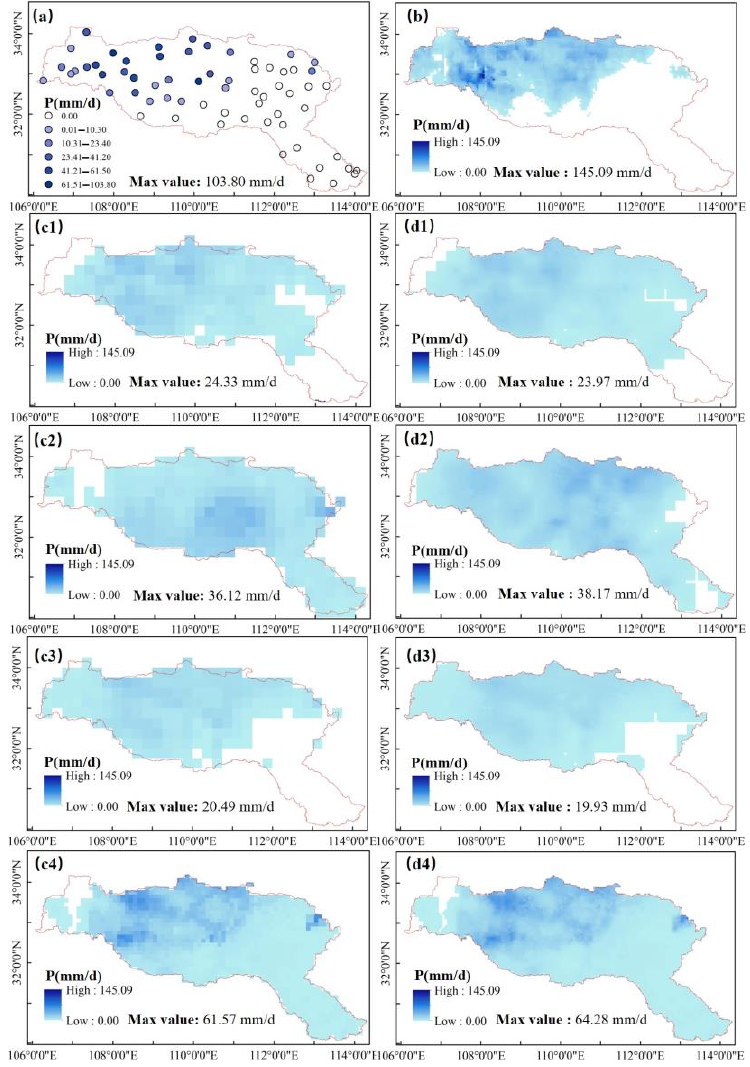
Figure 7. Spatial daily precipitation estimates from ( a ) the rain gauge observation, ( b ) the final MPP with 005 ◦ resolution, ( c1 ) the original 0.25 ◦ resolution TRMM_3B42, ( d1 ) the downscaled 0.05 ◦ resolution TRMM_3B42, ( c2 ) the original 0.25 ◦ resolution PERSIANN-CDR, ( d2 ) the downscaled 0.05 ◦ resolution PERSIANN-CDR, ( c3 ) the original 0.25 ◦ resolution CMORPH, ( d3 ) the downscaled 0.05 ◦ resolution CMORPH, ( c4 ) the original 0.1 ◦ resolution GPM, ( d4 ) the downscaled 0.05 ◦ resolution GPM, on 9 August